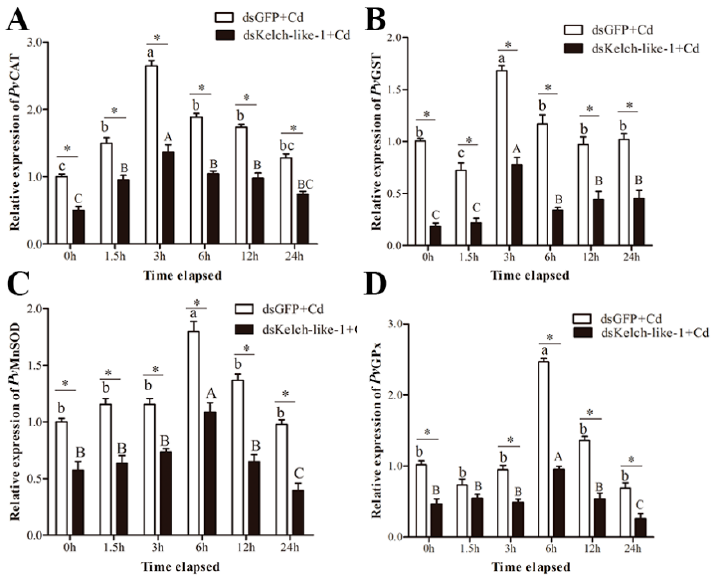
Figure 4. The mRNA expression of ( A ) Pv CAT (Catalase), ( B ) Pv MnSOD (Superoxide dismutase), ( C ) Pv GPx (Glutathione peroxidase) and ( D ) Pv GST (Glutathione S-transferase) in Pv Kelch-like-1-silenced shrimp after cadmium challenge. Vertical bars represent the mean ± SD ( n = 3). Different letters indicate statistically significant differences ( p < 0.05) between Cd challenged and unchallenged shrimp (0 h). Asterisks indicate statistically significant differences ( p < 0.05) between the two treatment groups.